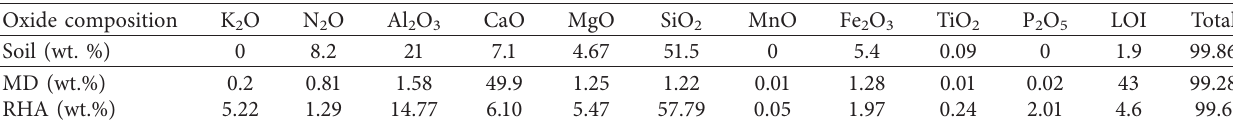
Table 2: Results of XRF analyses of expansive soil, marble dust, and rice husk